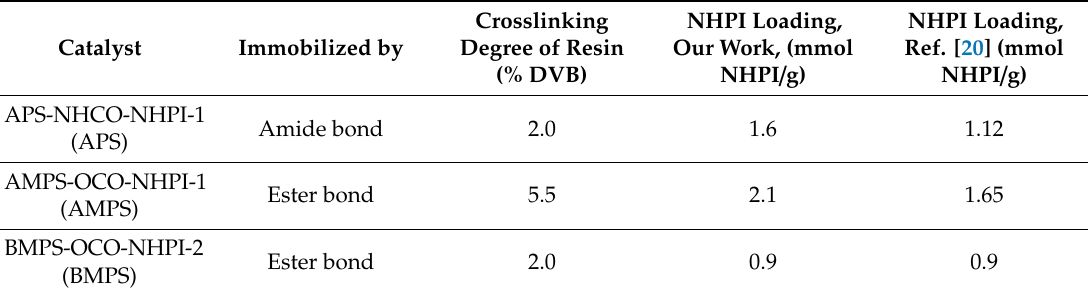
Table 1. Types of catalysts used in